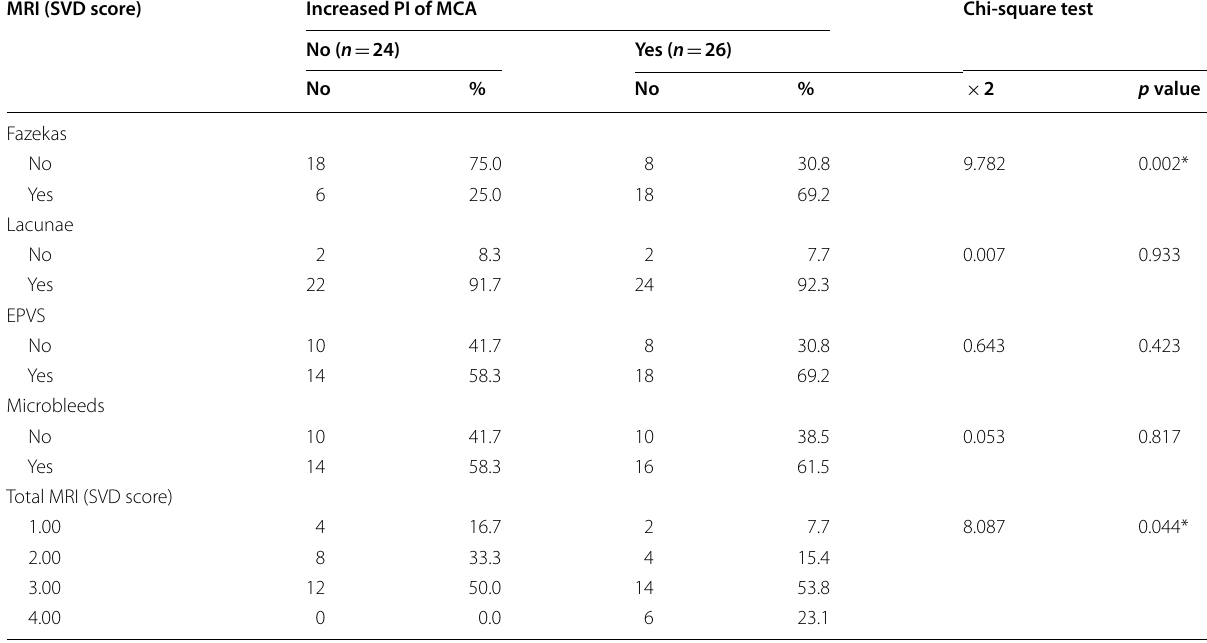
The asterisk denotes statistically significant value MRI magnetic resonance imaging, SVD small vessel disease, EPVS enlarged perivascular spaces